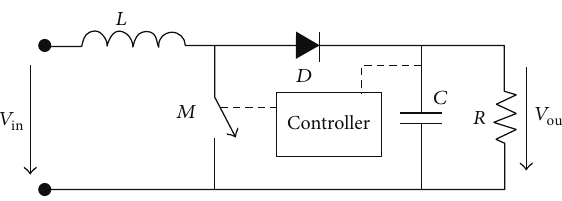
Figure 1: DC-DC boost converter topology, Brey et al.